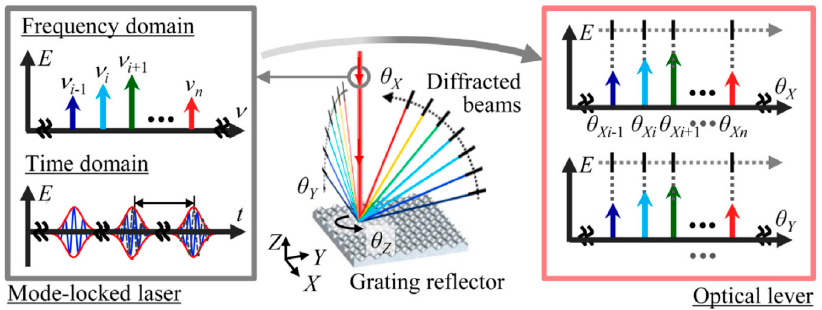
Figure 1. Angle scale comb generated from the equally-spaced optical modes of a mode-locked femtosecond laser in the frequency domain with the enhancement of the dispersive characteristics of a reflective-type diffraction grating [54].